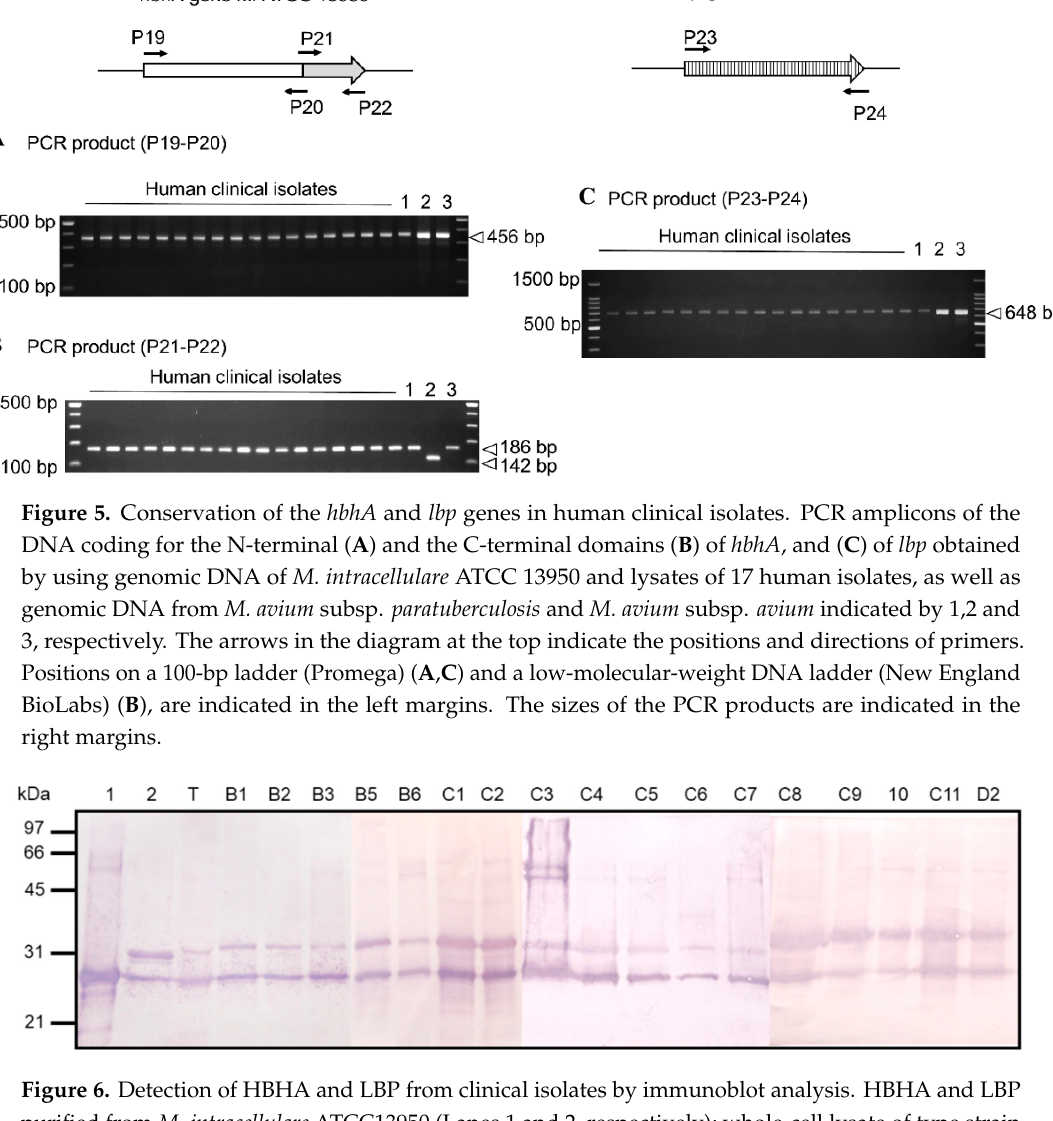
Figure 6. Detection of HBHA and LBP from clinical isolates by immunoblot analysis. HBHA and LBP purified from M. intracellulare ATCC13950 (Lanes 1 and 2, respectively); whole-cell lysate of type strain M intracellulare ATCC13950 used as control (lane T); whole-cell lysates of human clinical isolates (lanes B1 to D2). The immunoblots were probed with monoclonal antibody 3921E4. Sizes of molecular weight markers (kDa) are indicated in the left margin.